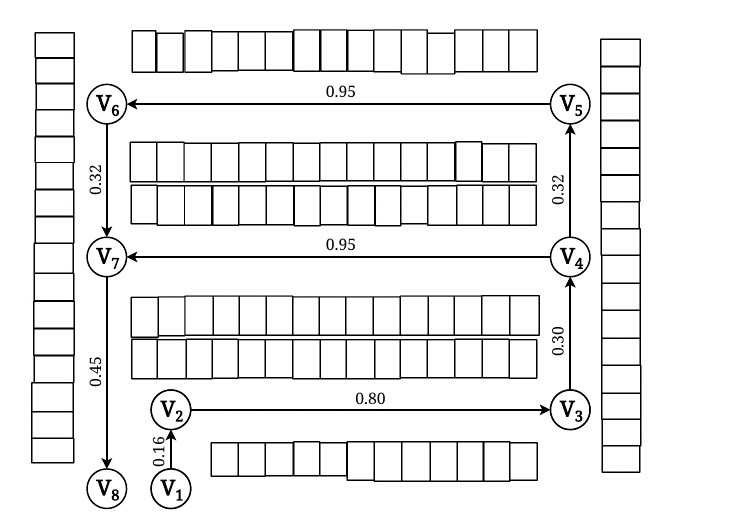
Figure 11. Illustration of the extracted parking spaces and modeled routes.